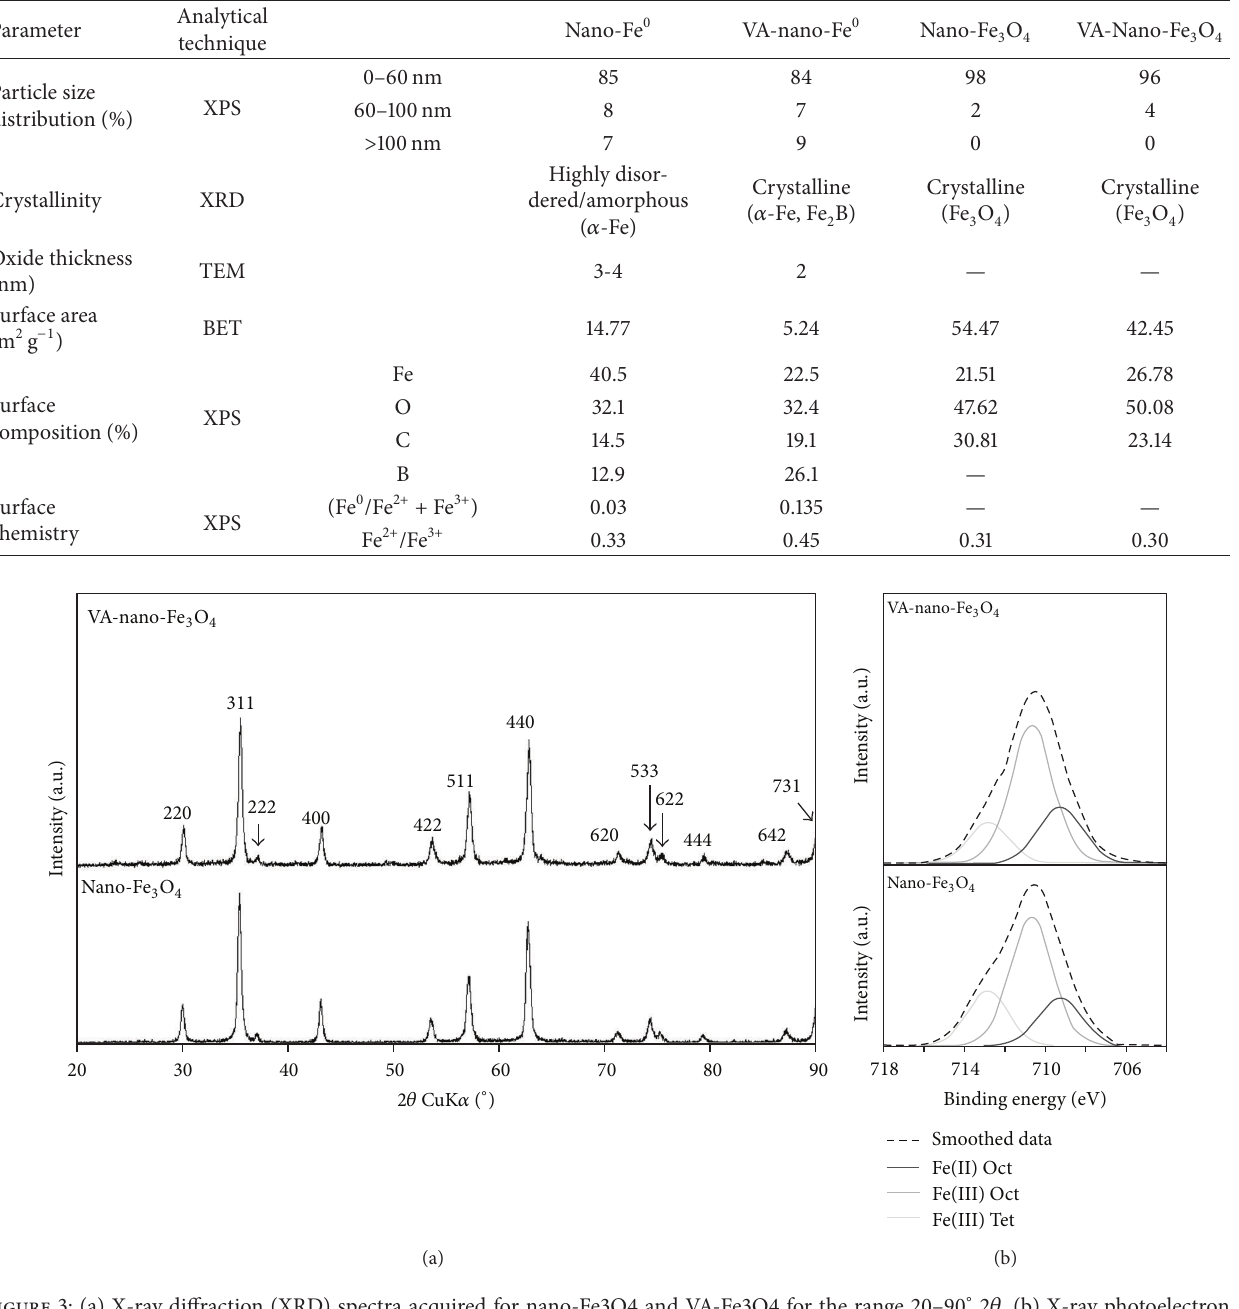
Figure 3: (a) X-ray diffraction (XRD) spectra acquired for nano-Fe3O4 and VA-Fe3O4 for the range 20–90 ∘ 2 𝜃 . (b) X-ray photoelectron spectroscopy (XPS) Fe 2p 3/2 photoelectron peaks for nano-Fe 3 O 4 and VA-Fe 3 O 4